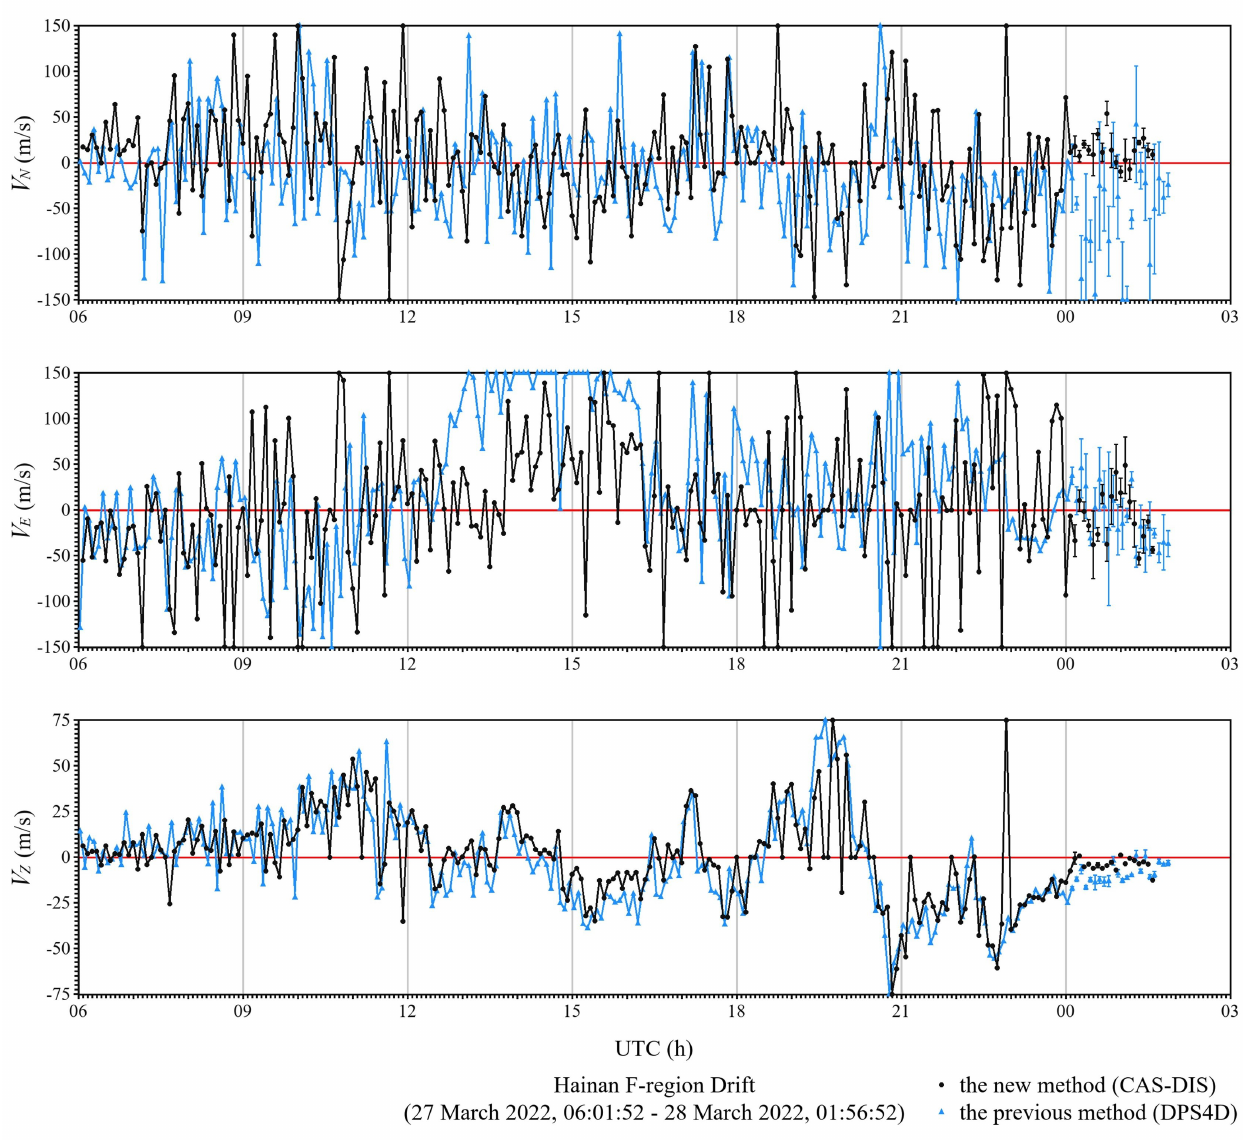
Figure 9. Statistics of the F-region drift velocity in Hainan from 27 March 2022, 06:01:52 to 28 March 2022, 01:56:52 in